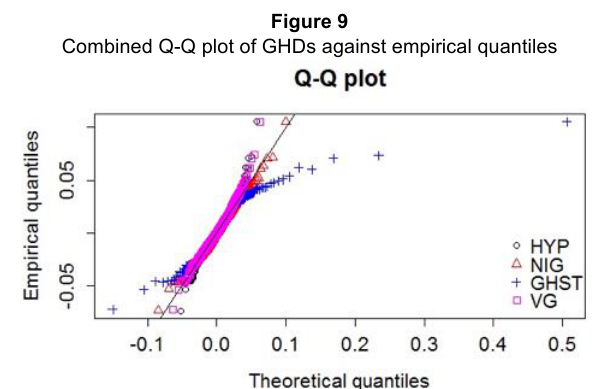
Combined Q-Q plot of GHDs against empirical